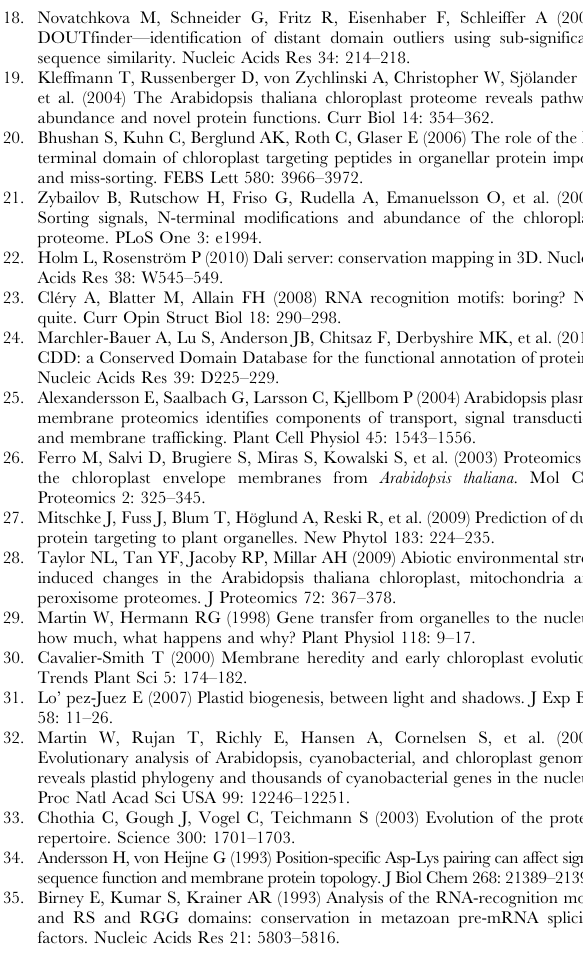
Figure S2 Cartoon of RNA-binding domain with bound RNA. Cartoon of HuD1,2–cfos-11 RNA complex structure [PDB code 1FXL; 3]. The RNA is shown as a stick model (orange). The N- & C- termini of the protein are marked as N and C, respectively. The two RRM domains form a cleft with the RNA bound between the b -sheets surfaces. In several RNA-binding proteins the two RRM domains are flexibly tethered via a linker